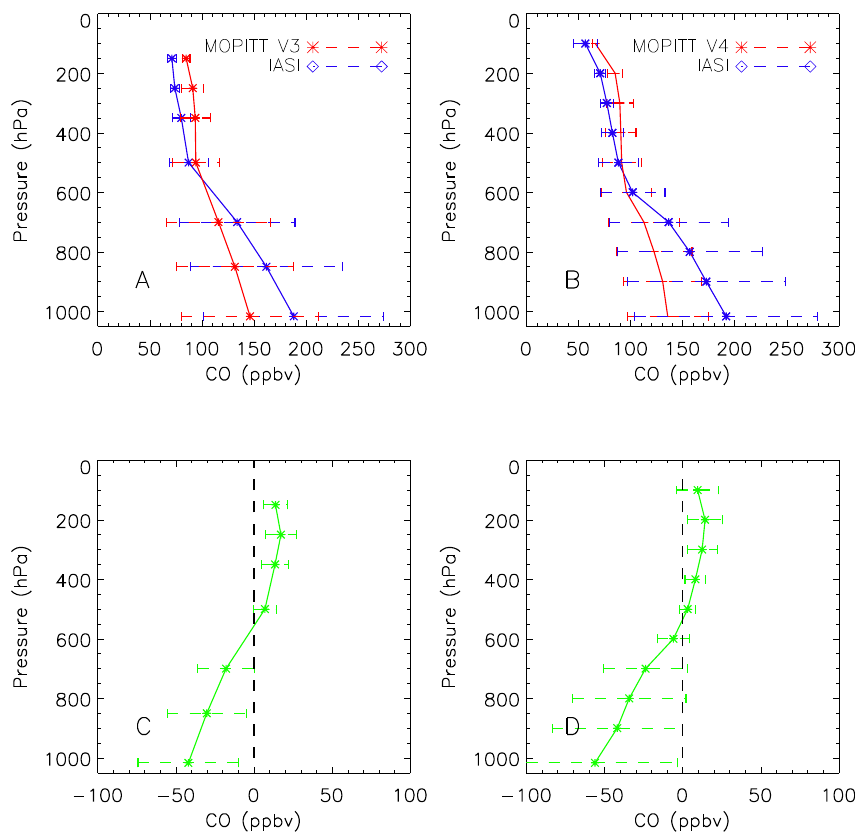
Fig. 9. Same as Fig. 8, except for x MOP’ and x IASI : (A) adjusted MOPITT V3 and IASI CO mean profiles; (B) adjusted MOPITT V4 MODEL MODEL and IASI CO mean profiles; (C) the mean difference between adjusted MOPITT V3 CO and IASI CO profiles; and (D) the mean difference between adjusted MOPITT V4 CO and IASI CO profiles. (A) and (B) are in relation to the retrieval of a true profile, as provided by GEOS-Chem. All comparisons are for over the ocean and during the daytime of 1 September 2007 , over the Southern Africa region.